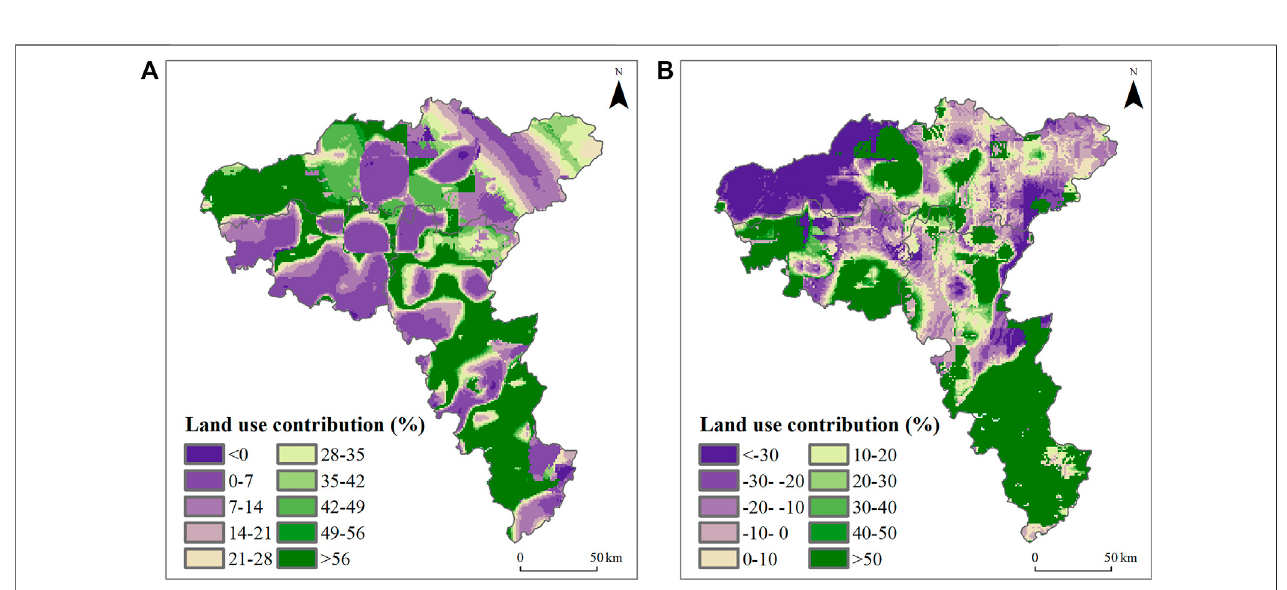
FIGURE 9 | Pixelwise contributions of LUCC impact during the period (A) 2001 – 2008 and (B) 2008 – 2014.